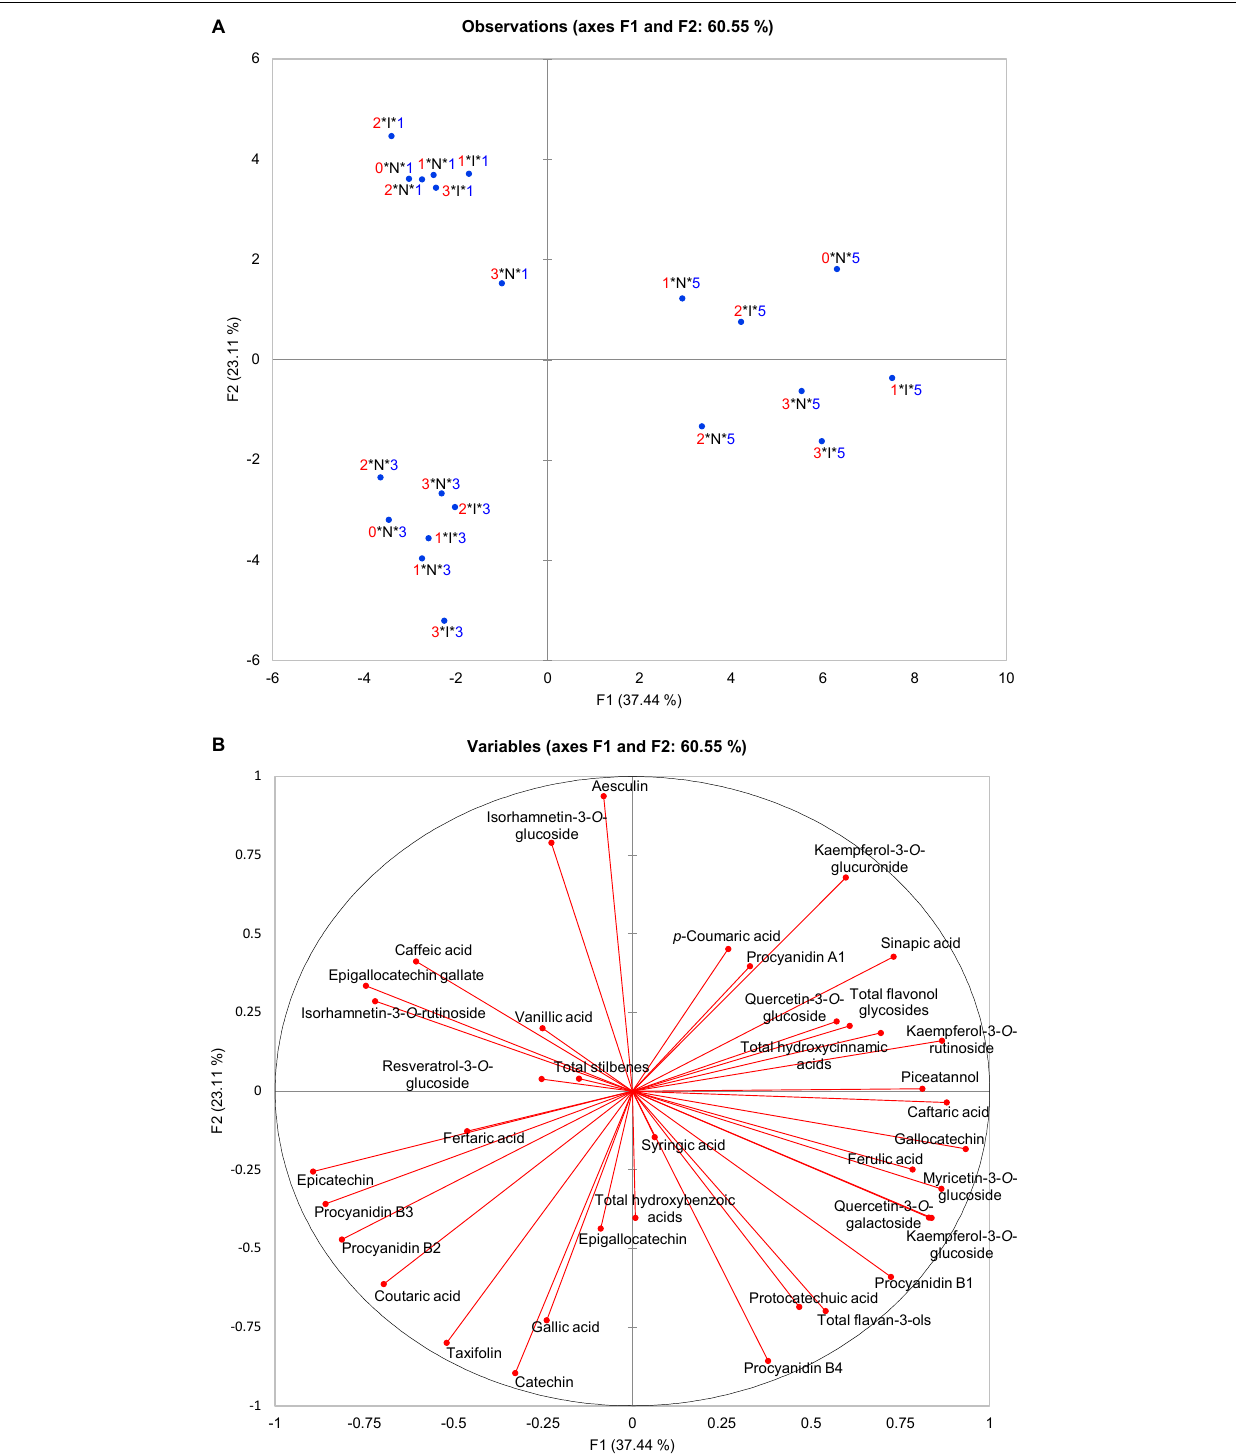
Frontiers in Plant Science |